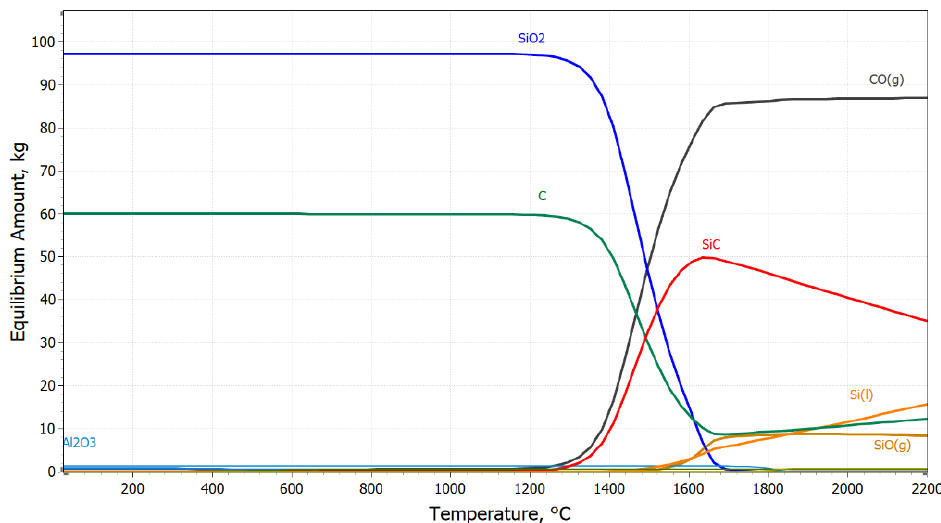
Figure 11. Gibbs equilibrium diagram of carbothermic reduction of quartzite Slovakia with an excess of reductant.